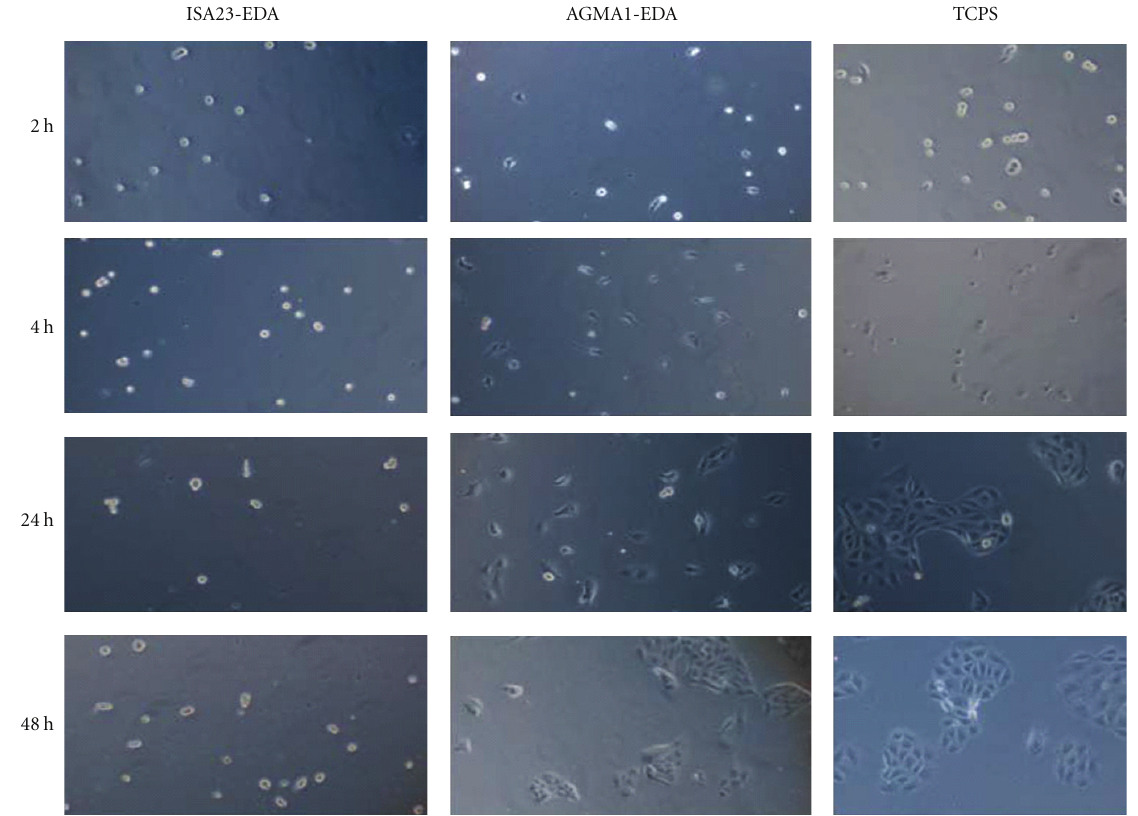
Figure 6: Optical microscopy images showing time evolution of MDCK cells on ISA23-EDA, AGMA1-EDA and TCPS [62].